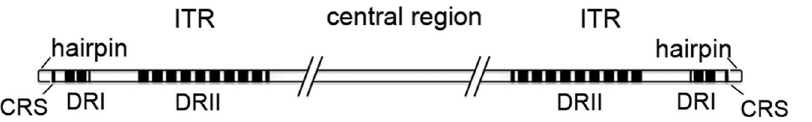
Figure 1. Representation of an orthopoxvirus genome. A typical genome consisting of a single dsDNA molecule with a concatemer resolution sequence (CRS), sets of direct repeats (DRI and DRII) and a hairpin loop on each inverted terminal repeat (ITR) is shown.